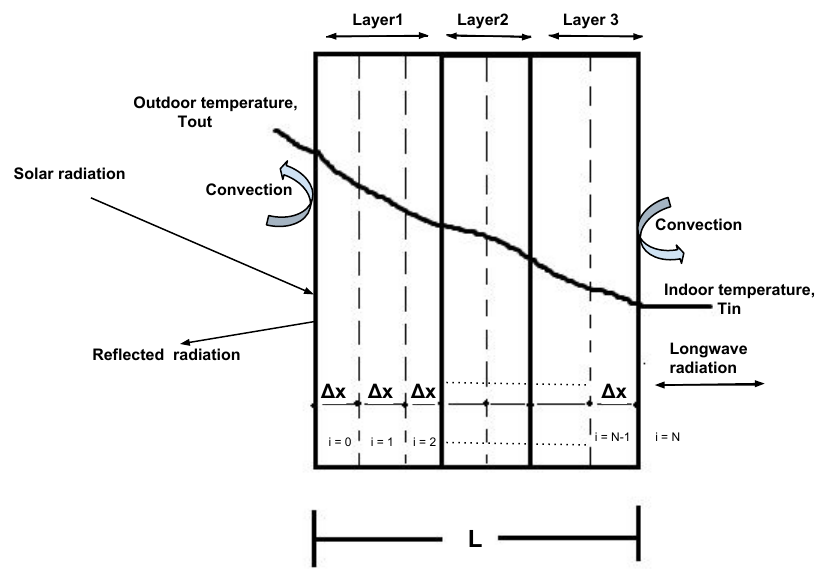
Figure 1. Heat flow through